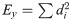
Error functions for bivariate regression.Shown are: Ey=∑di2, ED=∑Di2, Ex=∑hi2, and EA=12∑dihi.